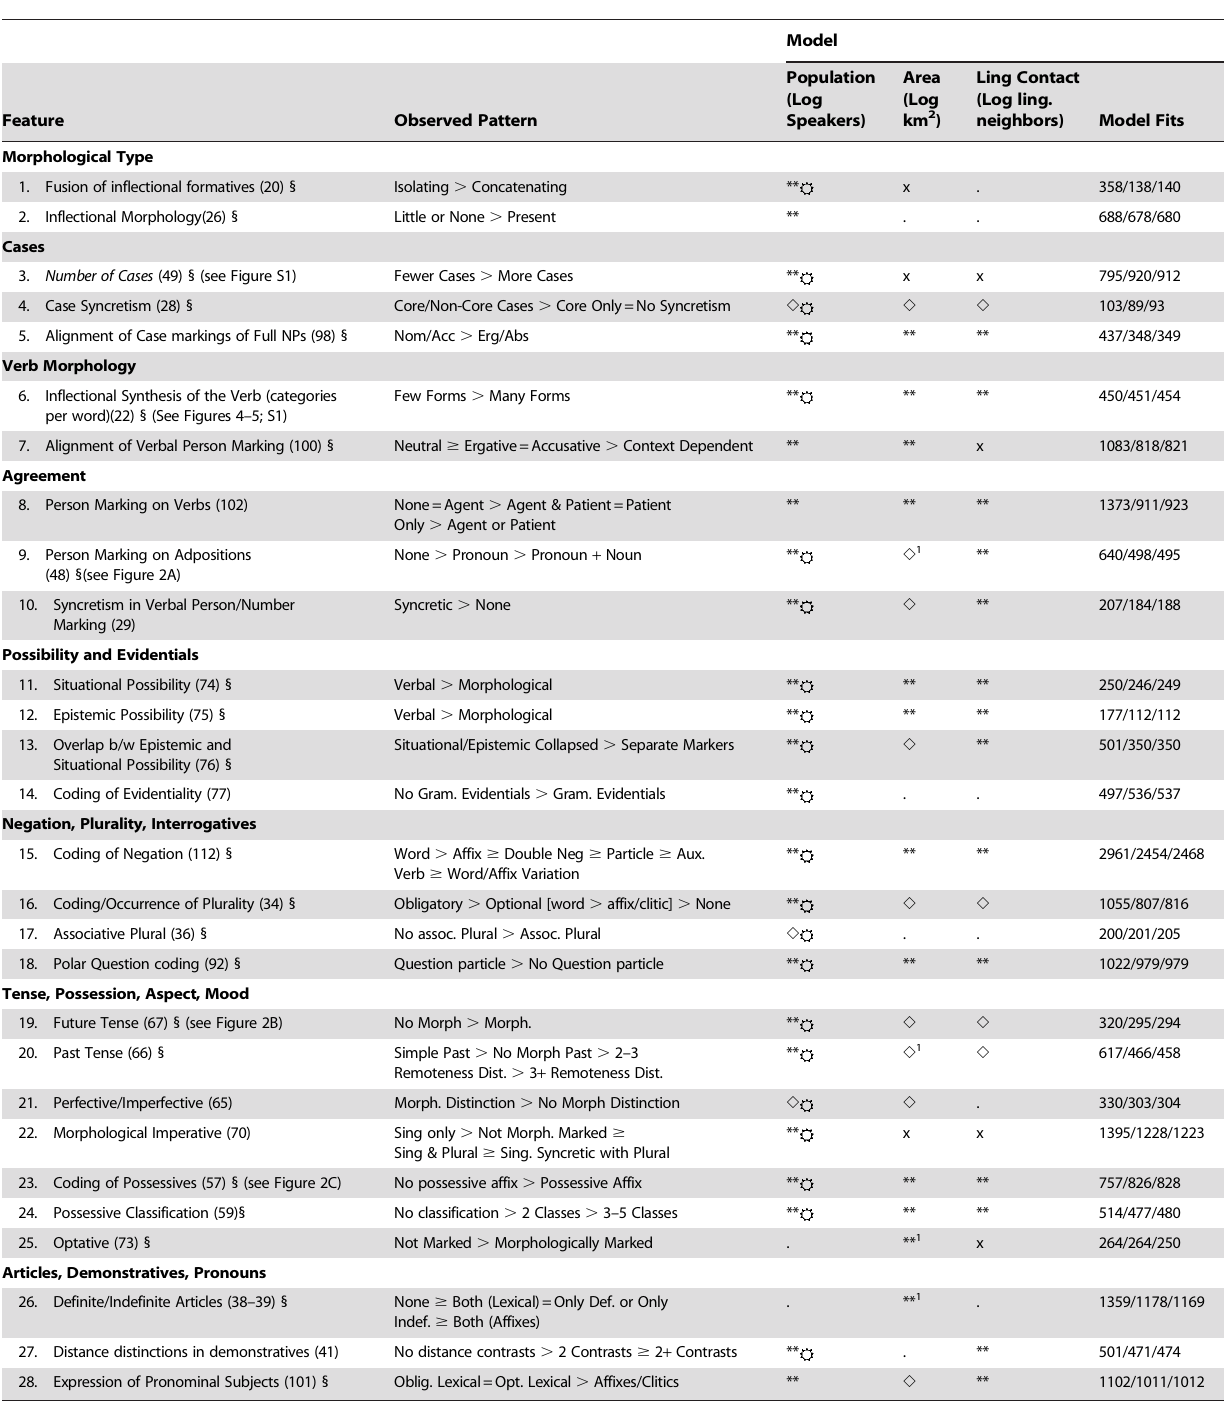
Table 1. Model fits are the Aikake information criteria of models predicting the linguistic feature from just the language family, from population alone, and from the three demographic variables,